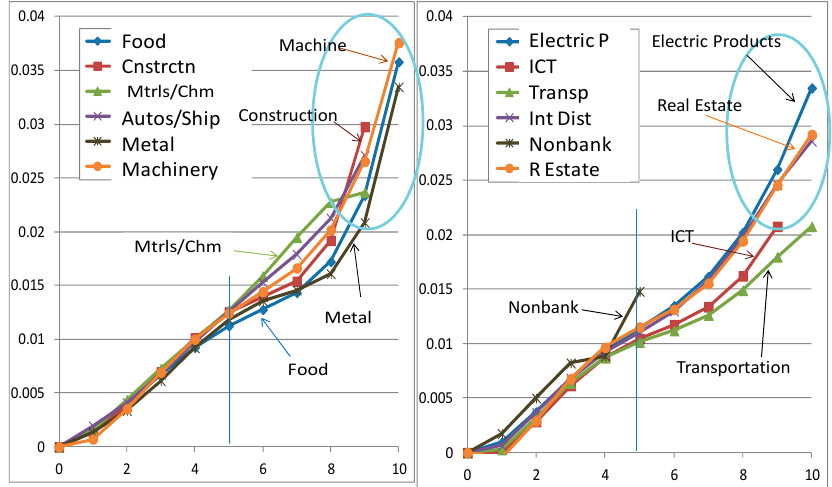
Figure 17. TSDPs of CG1–CG4.